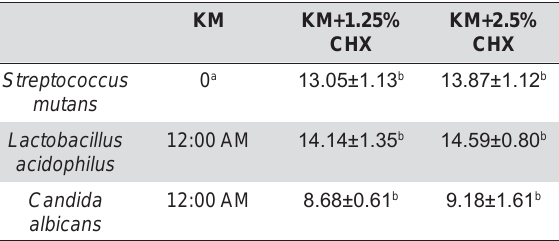
Table 1- (cid:3)(cid:48)(cid:72)(cid:68)(cid:81)(cid:86)(cid:3)(cid:147)(cid:3)(cid:86)(cid:87)(cid:68)(cid:81)(cid:71)(cid:68)(cid:85)(cid:71)(cid:3)(cid:71)(cid:72)(cid:89)(cid:76)(cid:68)(cid:87)(cid:76)(cid:82)(cid:81)(cid:86)(cid:3)(cid:82)(cid:73)(cid:3)(cid:76)(cid:81)(cid:75)(cid:76)(cid:69)(cid:76)(cid:87)(cid:76)(cid:82)(cid:81)(cid:3)(cid:93)(cid:82)(cid:81)(cid:72)(cid:86)(cid:3)(cid:11)(cid:80)(cid:80)(cid:12)(cid:3)(cid:73)(cid:82)(cid:85)(cid:3) the glass ionomer cements against the tested microorganisms, using agar diffusion tests